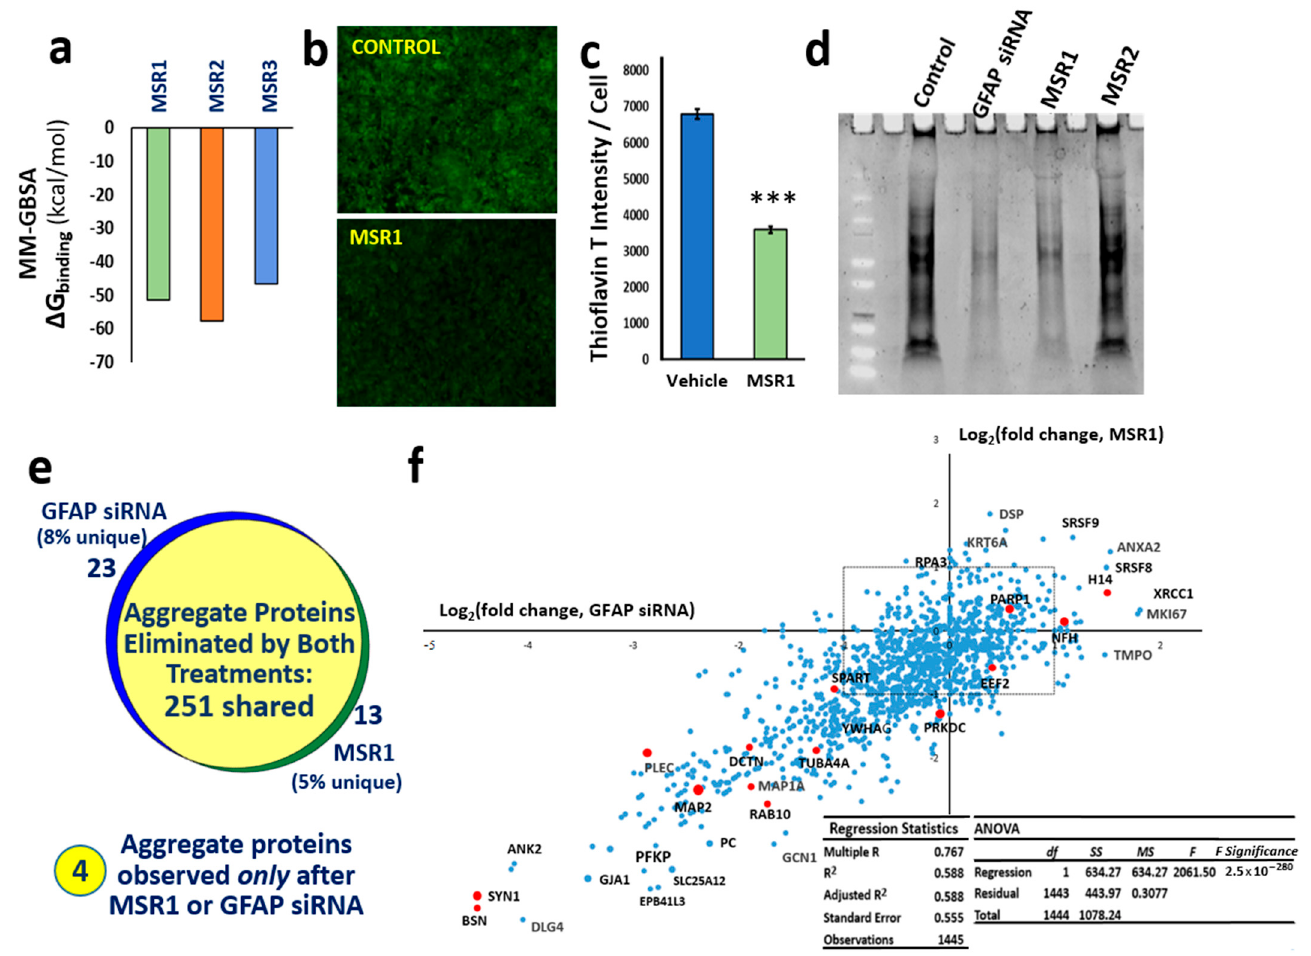
Figure 5. The drug MSR1 specifically binds GFAP and blocks its role in aggregation . ( a ) Histo ‐ gram shows stability (Gibbs free energy of binding) of the top three drugs from in silico screening for solvated MM ‐ GBSA docking to GFAP. The ChemBridge structural drug library was screened in three stages of progressively increased stringency, followed by counter ‐ screening to eliminate drugs with tubulin affinity. ( b ) SH ‐ SY5Y ‐ APP Sw cells were stained with Thioflavin T (green fluorescence) and counter ‐ stained with DAPI (not shown). ( c ) Histogram showing 2 ‐ fold reduction in amyloid per cell (thioflavin ‐ T fluorescence divided by the count of DAPI + nuclei per field); *** p ≤ 0.0005. ( d ) Total sarkosyl ‐ insoluble aggregate protein, electrophoresed and stained with SYPRO ‐ Ruby after isolation from SY5Y ‐ APP Sw cells. ( e ) The set of proteins totally removed from aggregates by siRNA knock ‐ down of GFAP is nearly identical to the set eliminated by MSR1. The Venn diagram shows proteo ‐ mic overlap of 251 proteins identified in sarkosyl ‐ insoluble aggregates from untreated SY5Y ‐ APP Sw cells ( ≥ 7 hits) but not detected 48 h after transfection with GFAP siRNA or after treatment with 1 μ M MSR1. Conversely, four proteins absent from untreated cell aggregates were identified in both treated cell groups. ( f ) Linear regression of log 2 (fold change) of aggregate protein abundance after GFAP siRNA treatment (X ‐ axis) vs. MSR1 treatment (Y ‐ axis). Selected proteins are labeled, includ ‐ ing many found by aggregate cross ‐ linking [57] to be immediate neighbors of GFAP (red dots). Dots within the dashed rectangle were shifted <2 ‐ fold by either treatment. R = 0.77 for the regression; F ‐ test significance was p < 3 × 10 − 280 .